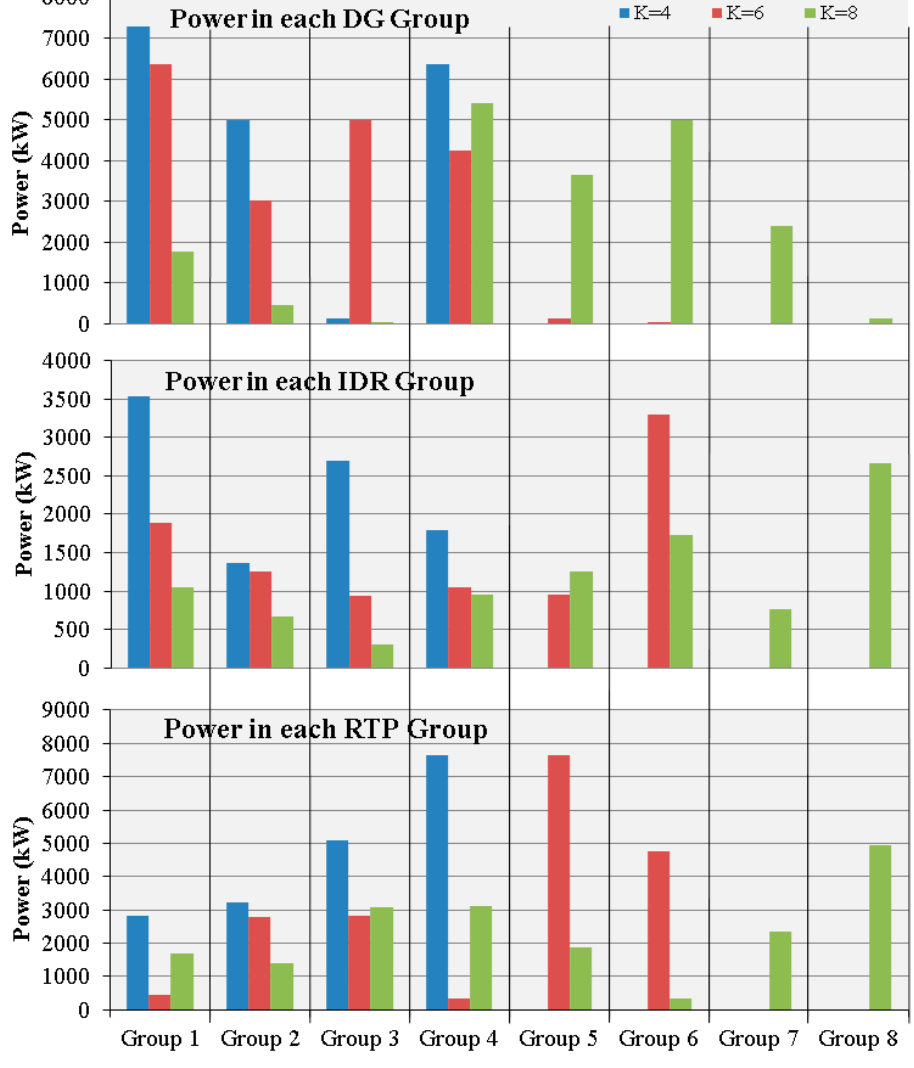
Figure 4. Power in each group.